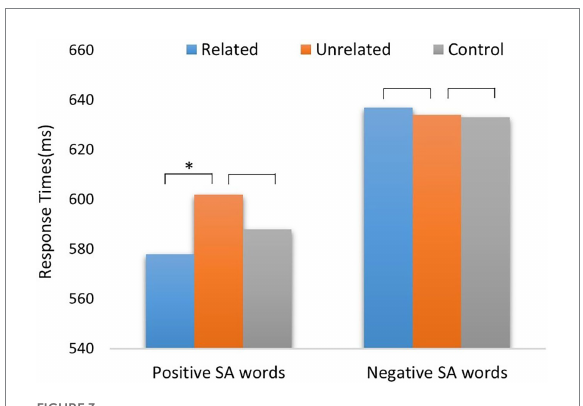
FIGURE 3 Trial procedure for Experiment 1. “ 童 (tong2) 年 (nian2) means “childhood.”